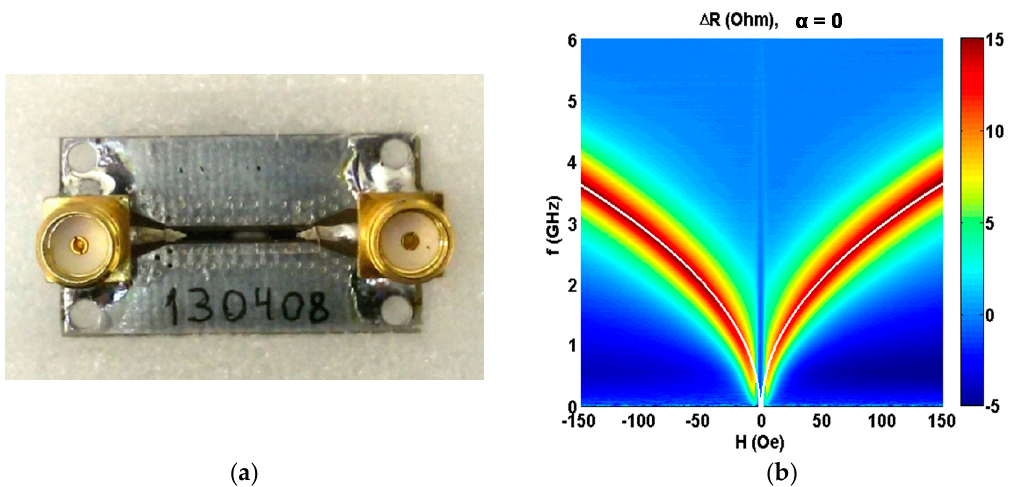
Figure 2. The general view of coplanar holder with installed [Ti/FeNi] 6 /Ti/Cu/Ti/[FeNi/Ti] 6 multilayered GMI element ( a ). Experimental field and frequency dependences of the increment of active component for the line impedance Δ R measured with multilayered GMI element as a part of the transmission line: An external in plane magnetic field is oriented along the long side of the GMI element, i.e., in configuration of α = 90° (see also Figure1a). Fitting by the Equation (5) is shown as the white line ( b ).